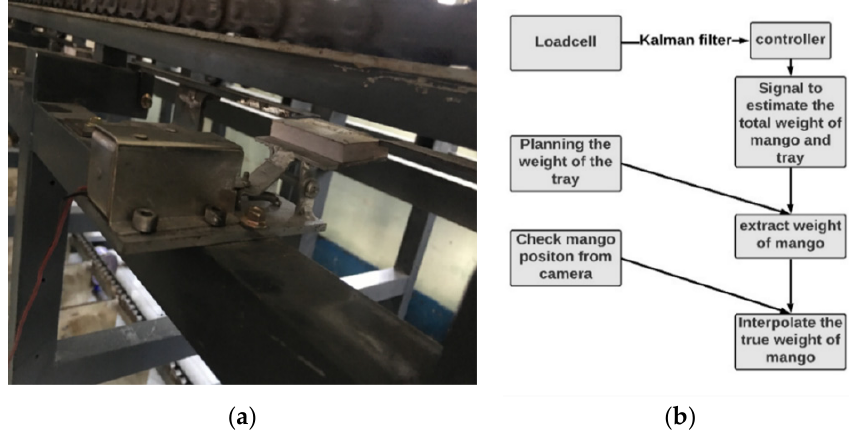
Figure 2. The process of weight system. ( a ) The load-cell in system; ( b ) flowchart of load-cell signal Figure2. Theprocessofweightsystem. ( a )Theload-cellinsystem;( b processing.